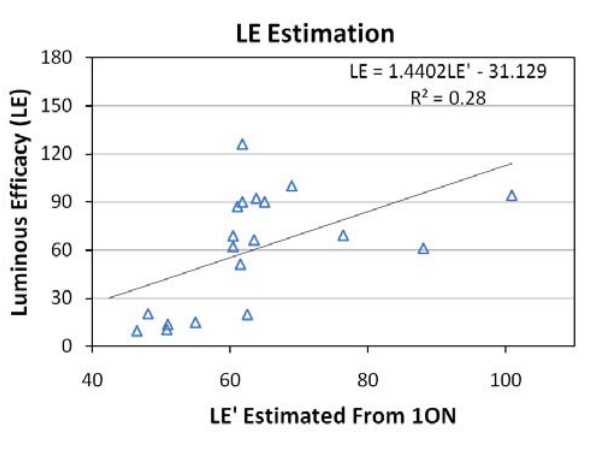
Figure 20. LE estimated from the 1ON band combination versus the LE calculated from manufacturer reported lumen output and consumption